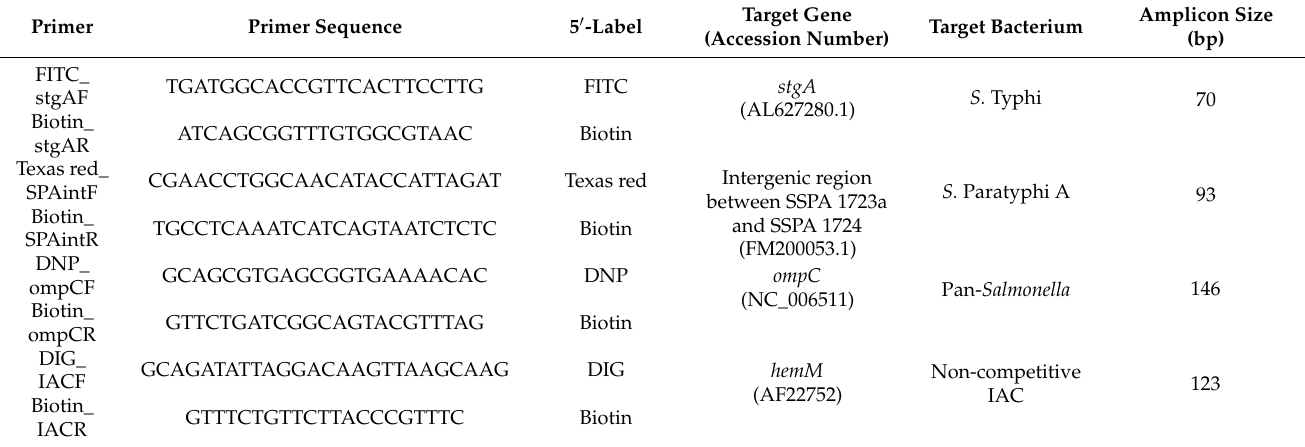
Table 1. Primers used in the